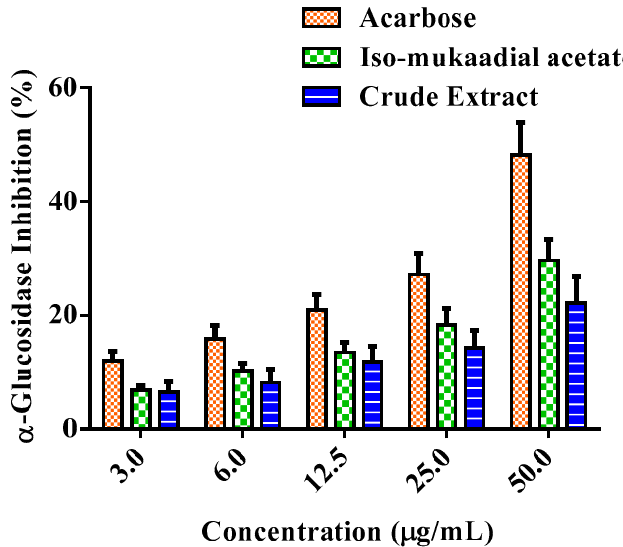
Figure 7. Percentage α -glucosidase inhibitory effect of standard compound of acarbose, iso-mukaadial acetate, and crude extract. Values are presented as means, and vertical bars indicate SEM, p < 0.05.